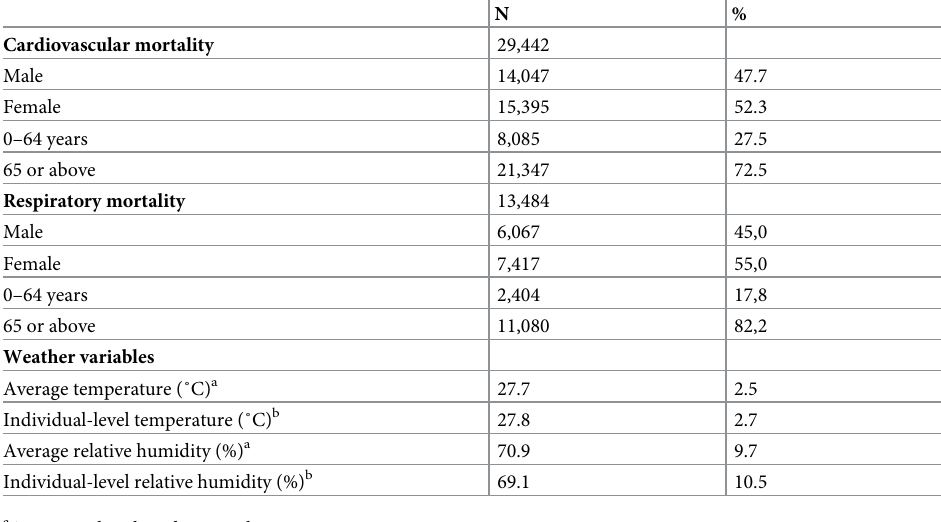
Table 1. Study population summary statistics and weather variables in Rio de Janeiro, Brazil, 2012–2017. The data were restricted to the hot season (November to March).